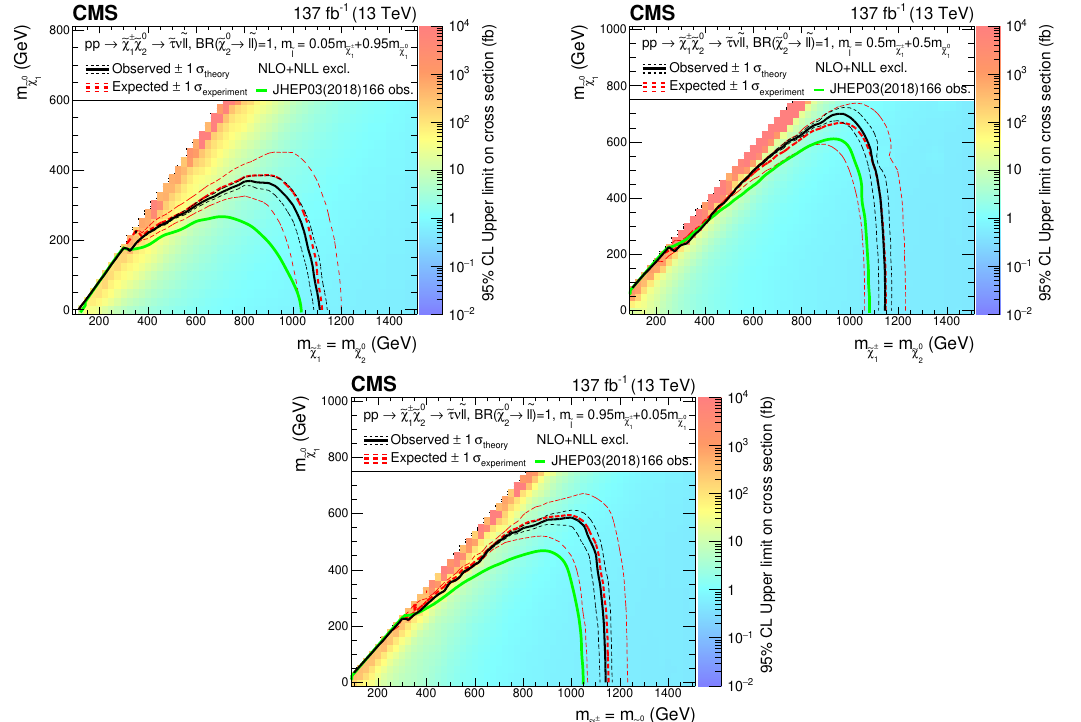
0 production with τ -enriched slepton-mediated Figure 17 . Interpretation of the results for e c ± 2 1 e c decays, and the parameter governing the mass splittings being x = 0 . 05 (upper left), x = 0 . 5 (upper right) and x = 0 . 95 (lower). The shading in the m versus m plane indicates the 95% 0 0 e c e c 1 2 ± 0 CL upper limits on the production cross sections. The contours delineate the mass regions e c 2 1 e c excluded at 95% CL when assuming cross sections computed at NLO plus NLL. The observed, observed ± 1 σ ( ± 1 standard deviation of the theoretical cross sections), median expected, and theory expected ± 1 σ bounds are shown in black and red. The observed limits obtained in the experiment CMS analysis using 2016 data [20] are shown in